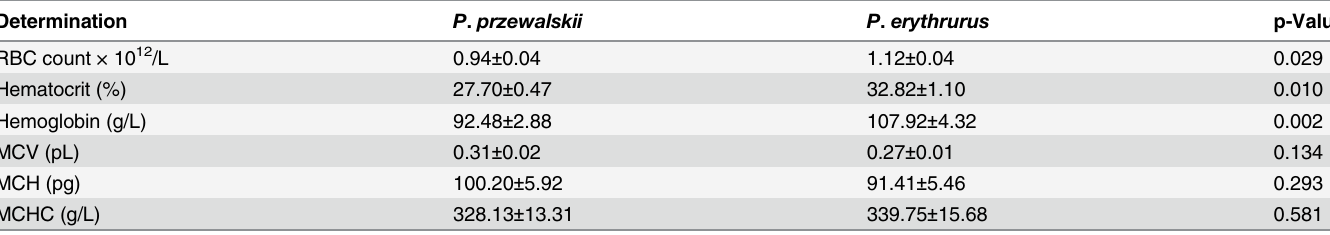
Table 3. Hematological parameters of P . erythrurus and P . przewalskii . Determination